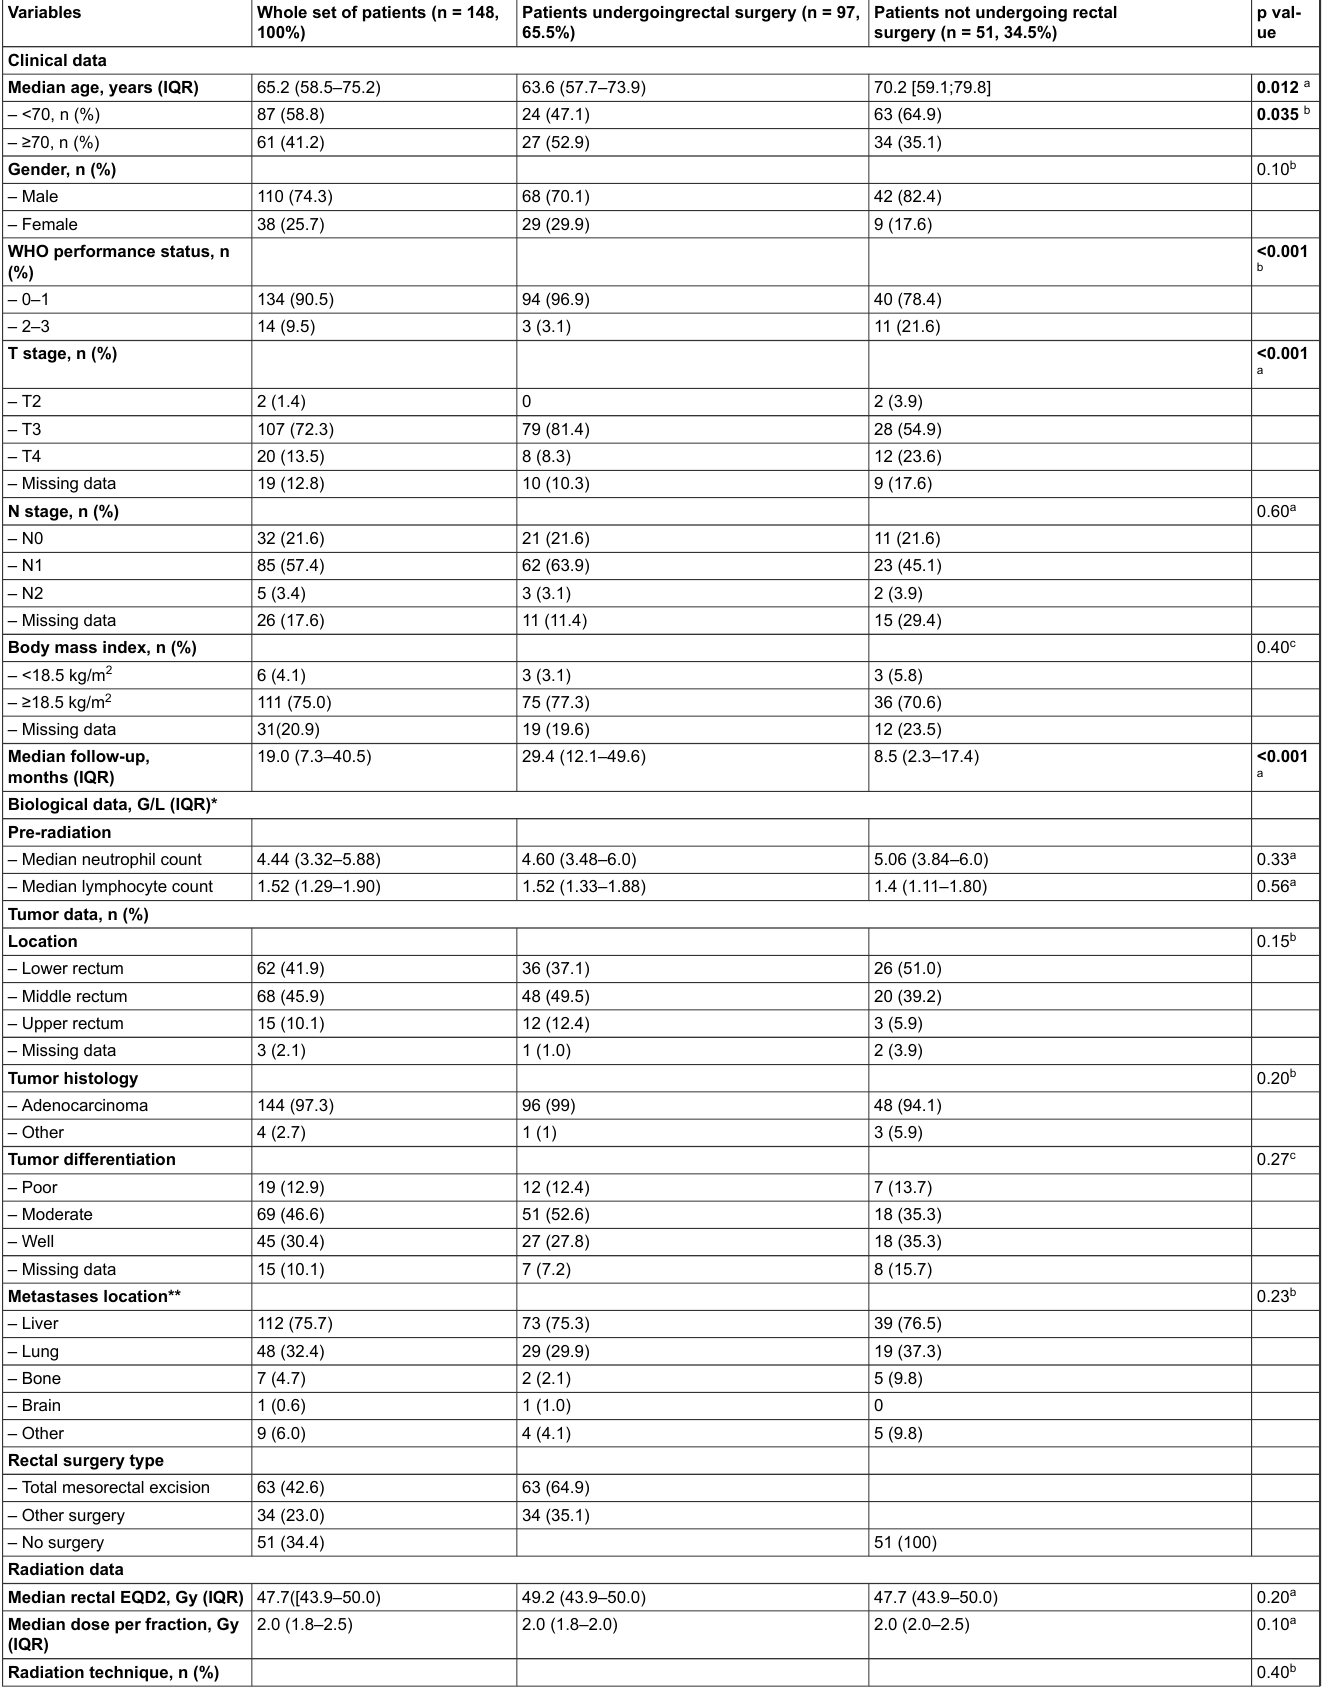
Table 1: Patient, tumour and treatment